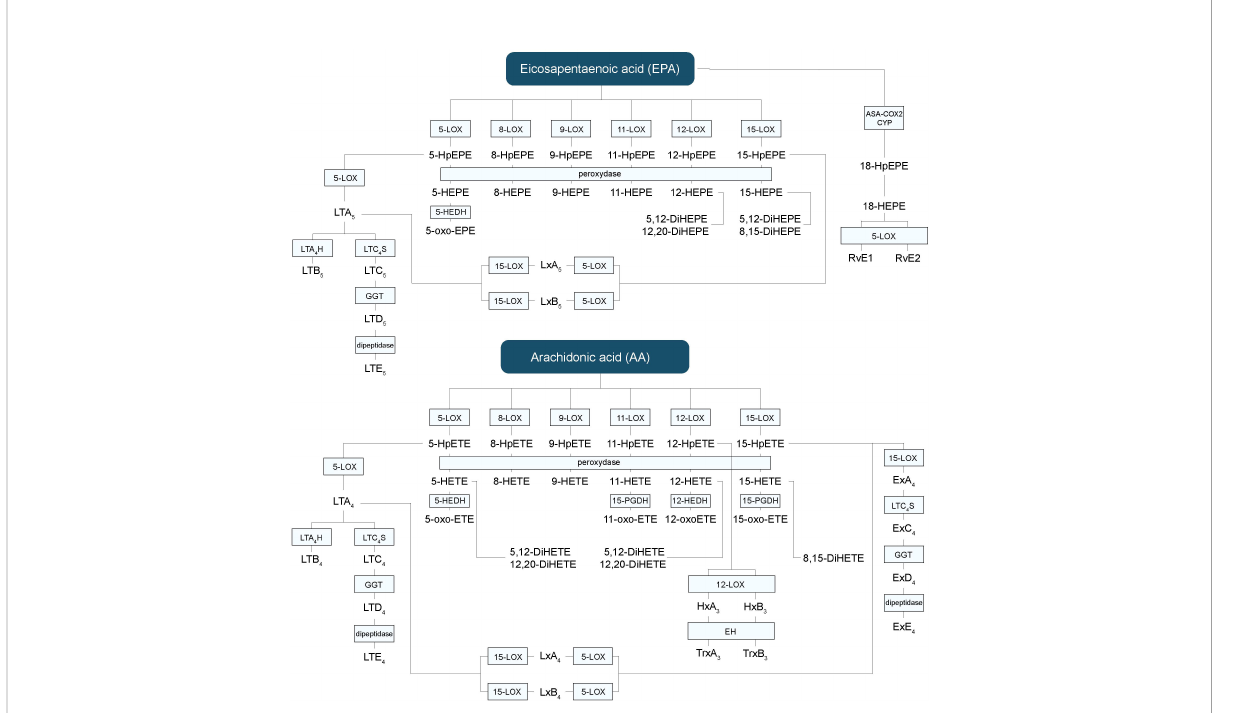
FIGURE 3 Hydroxy-fatty acids, leukotrienes and other lipid mediators ’ biosynthetic pathways derived from EPA and AA. AA, arachidonic acid; CYP, P450 cytochrome; DiHETE, dihydroxyeicosatetraenoic acid; DiHEPE, dihydroxyeicosapentaenoic acid; EPA, eicosapentaenoic acid; Ex, eoxin; HEPE, hydroxy-eicosapentaenoic acid; HETE, hydroxy-eicosatetraenoic acid; HpETE, hydroxy-peroxy-eicoisatetraenoic acid; HpEPE, hydroxy-peroxy- eicoisapentaenoic acid; LT, leukotriene; LOX, lipoxygenase; Lx, lipoxin; oxo-ETE, oxo-eicosatetraenoic; oxo-HEPE,